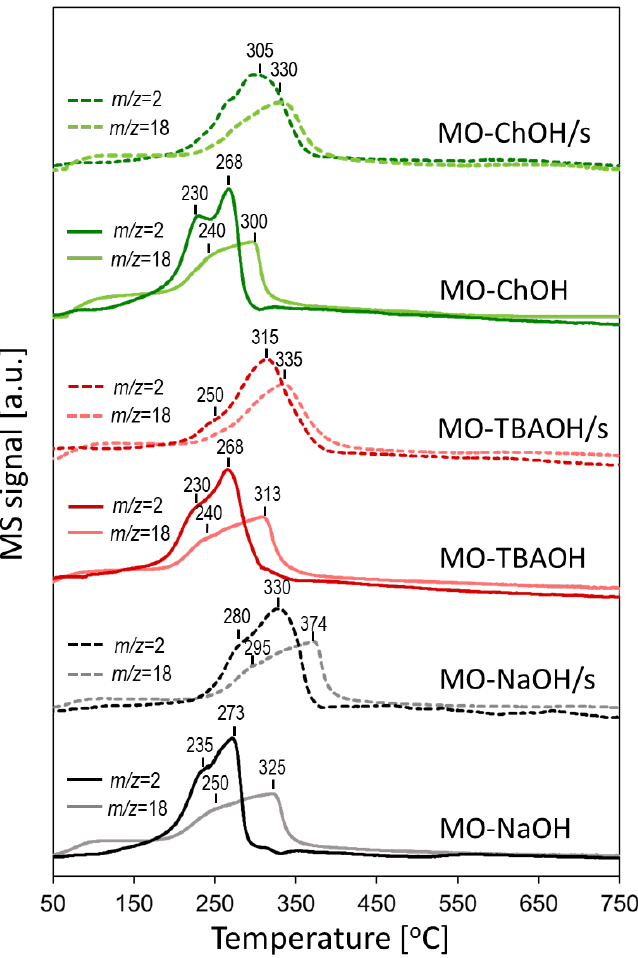
Figure 9. TPR-MS profiles of H 2 consumption ( m/z = 2) and H 2 O release ( m/z = 18) by mixed oxides obtained by the calcination of precursors at 450 °C.